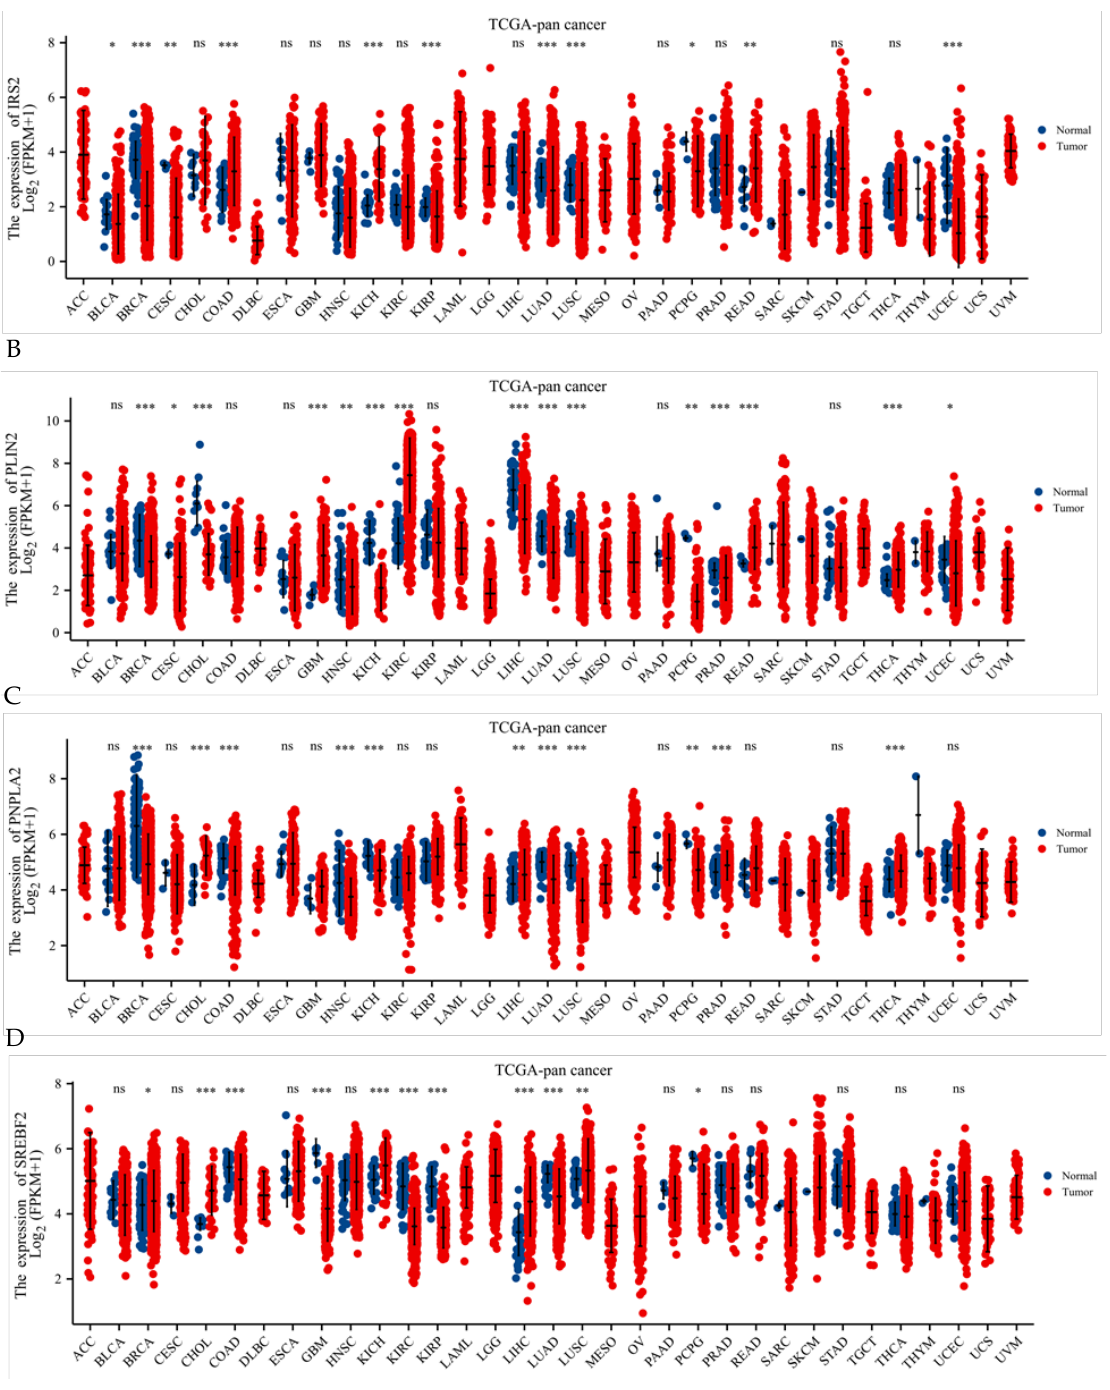
Figure 8. Pan-cancer analysis of the expression of four hub genes. ( A ) Pan-cancer analysis of Irs2 ; ( B ) pan-cancer analysis of Pnpla2 ; ( C ) pan-cancer analysis of Plin2Srebf2 . ( D ) Pan-cancer analysis of Srebf2 . * p < 0.05; ** p < 0.01; *** p < 0.001; ns p >